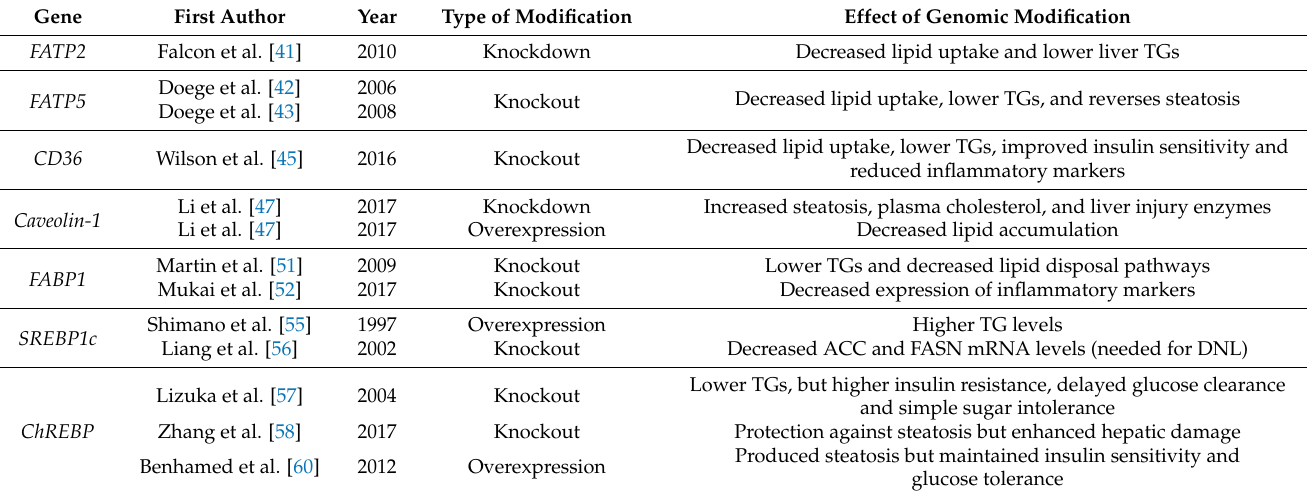
Table 4. Summary of Genomic Approaches for Liver